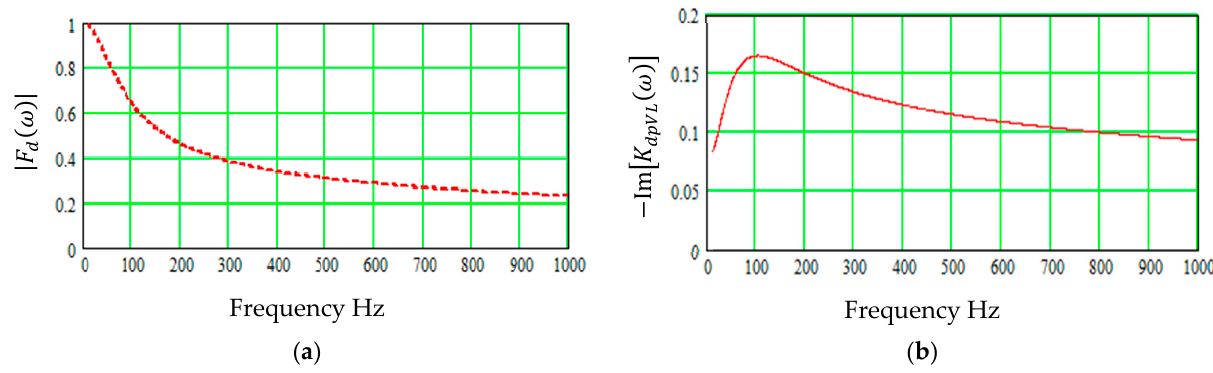
Figure 2. ( a ) Plot of the modulus of the pressure diffusion correction function, | F d ( ω ) | , against frequency for a vertical-wall labyrinthine slit ( w = 1 mm, b = 3 mm, l = 45 mm, N = 10) in a slanted slit pore matrix (0.04 mm wide slits at 70 ◦ to the normal, porosity 0.9). ( b ) Plot of the corresponding imaginary part of the double porosity bulk modulus.